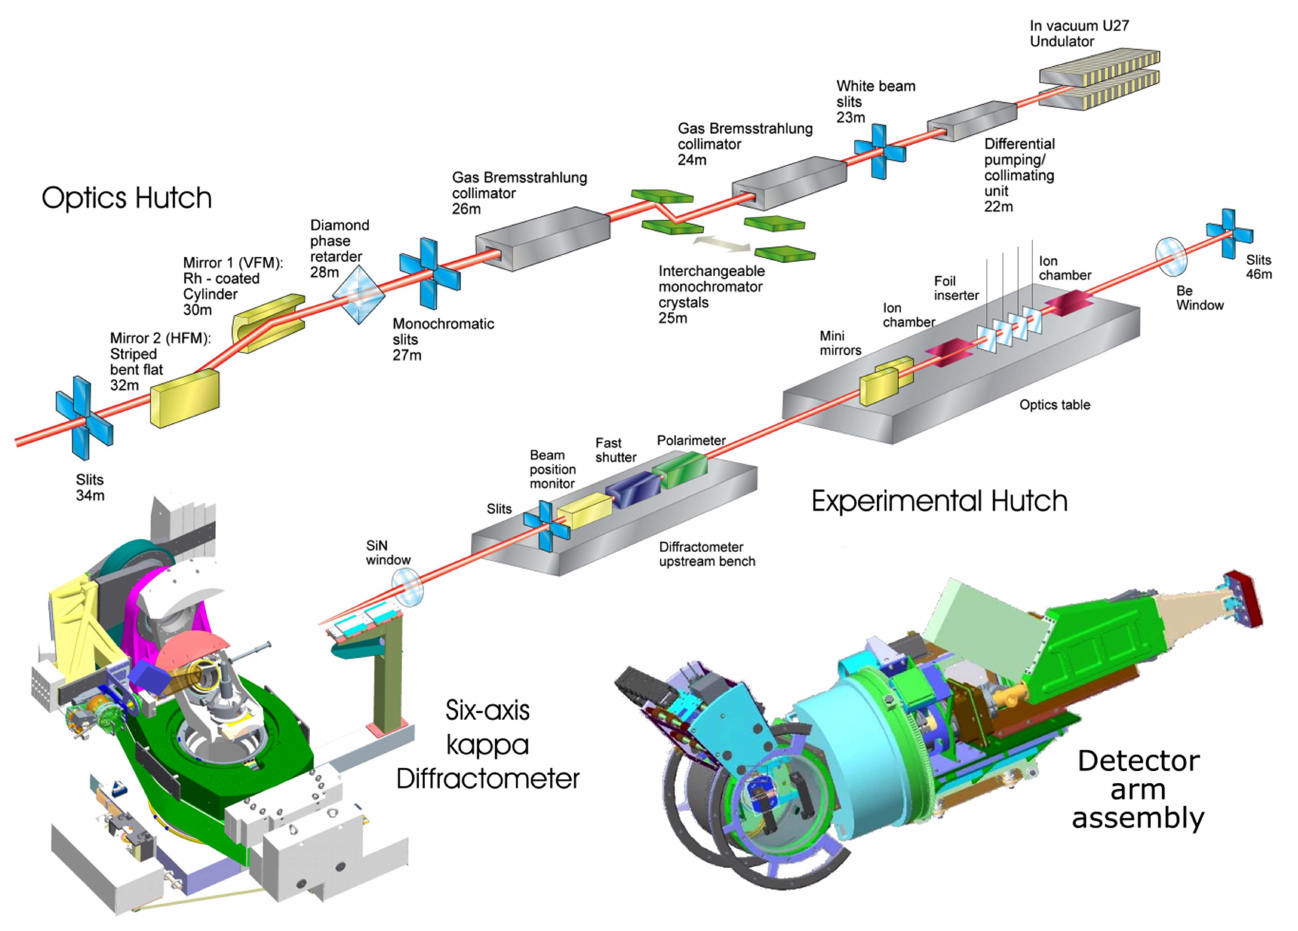
Figure 6 I16 beamline layout at DLS. The undulator radiation passes through primary adjustable slits and is nearly completely absorbed by the first Si